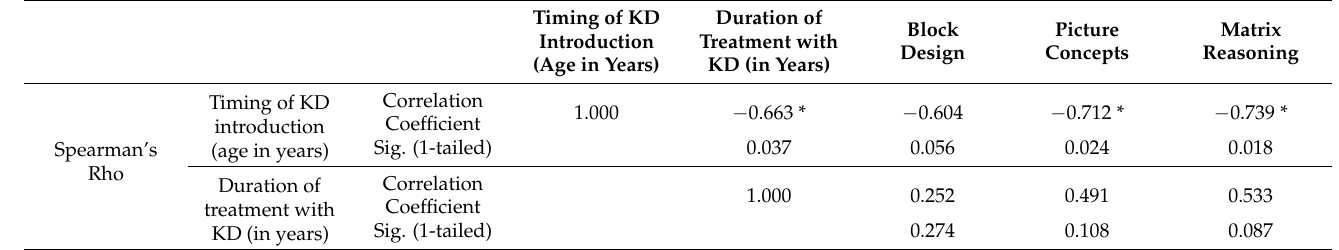
Table 5. Correlation between subtests of perceptual reasoning index (PRI) and timing of KDT introduction/duration of treatment with